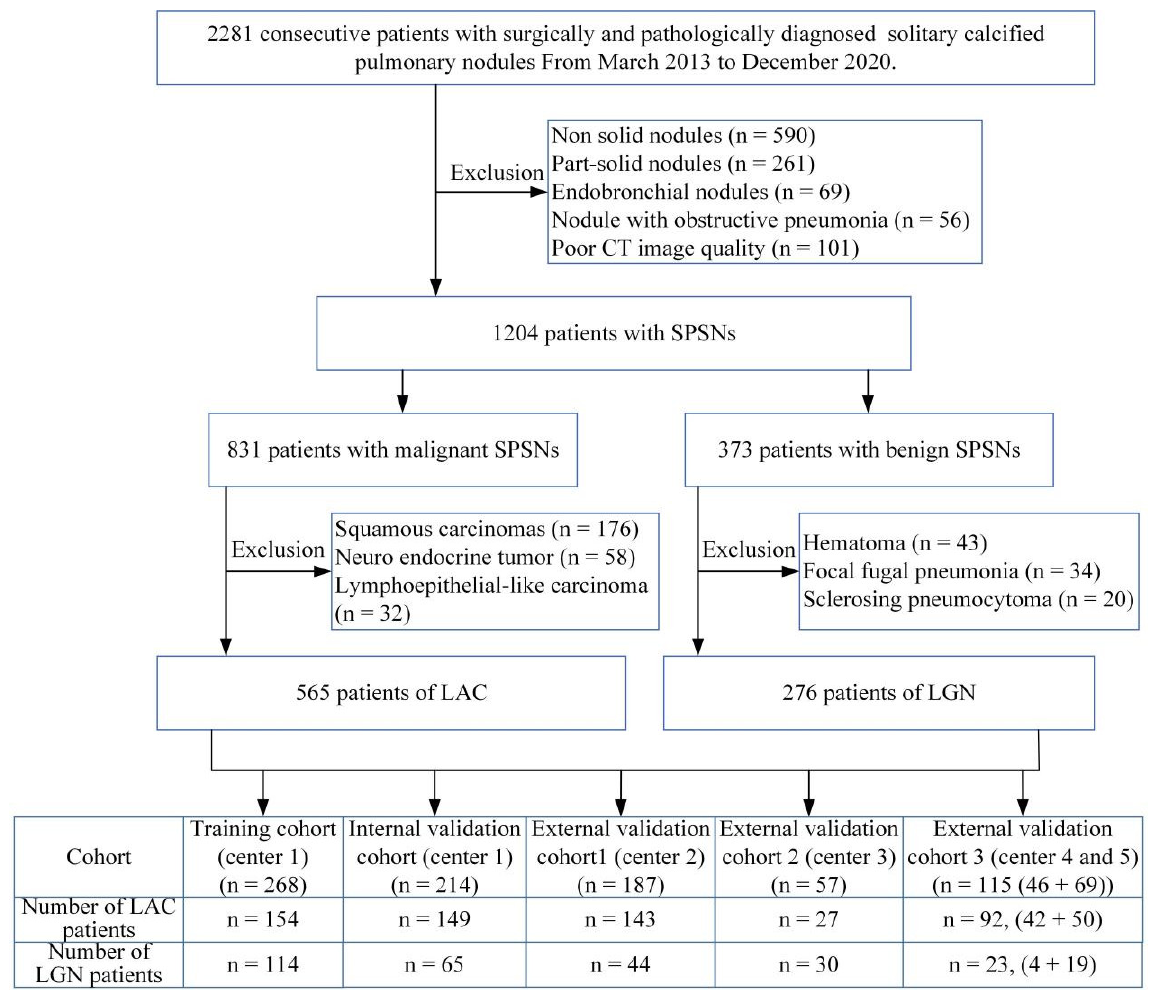
Figure 1. Flow diagram of the patient inclusion and exclusion process. Note: CT, computed tomography; SPSNs, solitary pulmonary solid nodules; LAC, lung adenocarcinoma; LGN, lung granulomatous nodule.